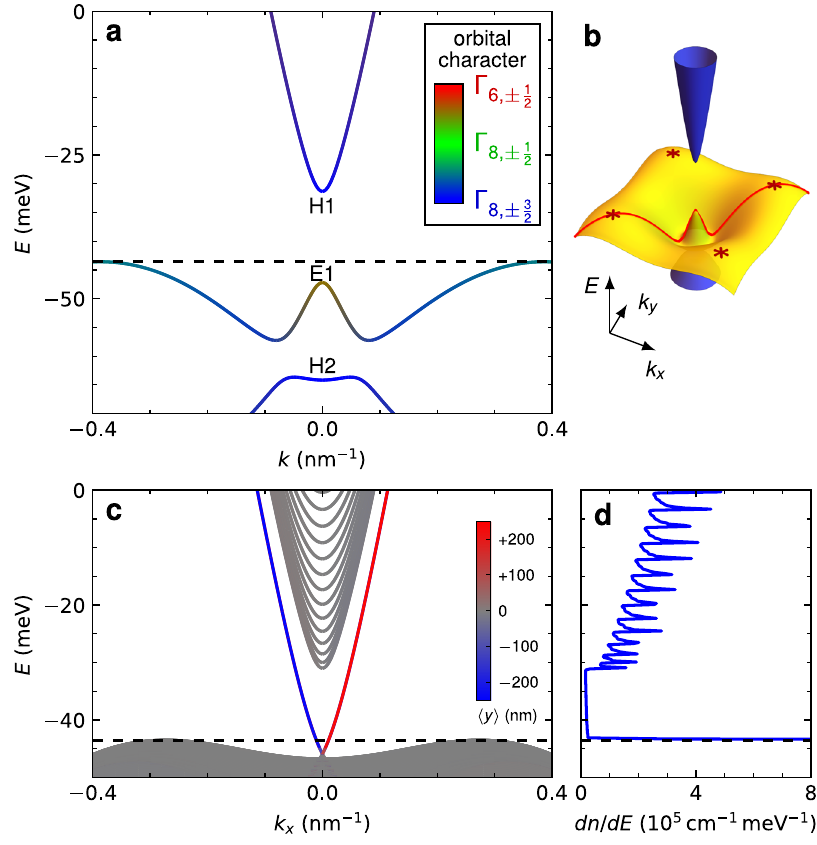
Fig. 1 Band structures calculated with the k (cid:3) p method. a Dispersion for an in fi nite (Hg,Mn)Te quantum well, 9 nm thick and with 1.2% Mn, along the axis ffiffiffi p ffiffiffi p ð k ; k Þ ¼ k ð cos45 (cid:2) ; sin45 (cid:2) Þ ¼ k ð 1 = ; 1 = Þ . The colors indicate the orbital character, see legend. b Three-dimensional rendering of the band structure. 2 2 x y We highlight the axis of part a , (red curve) and the camel back points (stars). c Dispersion in the strip geometry, 500 nm wide. The colors indicate the eigenstate location 〈 y 〉 , see legend. d Density of carriers dn / dE for the strip geometry. Just below the camel back ( E ≈ − 46 meV, dashed lines), the density reaches values > 400 × 10 5 cm − 1 meV − 1 , out of scale in this